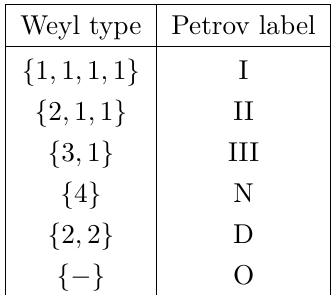
Table 1 . Different types of Weyl spinor classified by: (i) the pattern of degenerate principal null directions; (ii) the equivalent Petrov